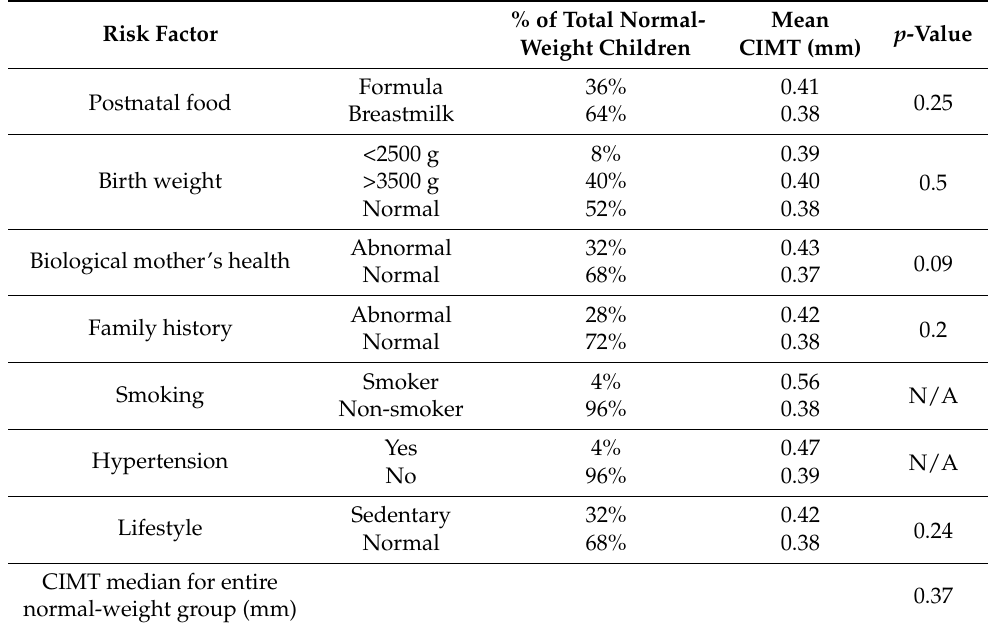
% of Total Normal- Mean p -Value Weight Children CIMT (mm) Formula 36%